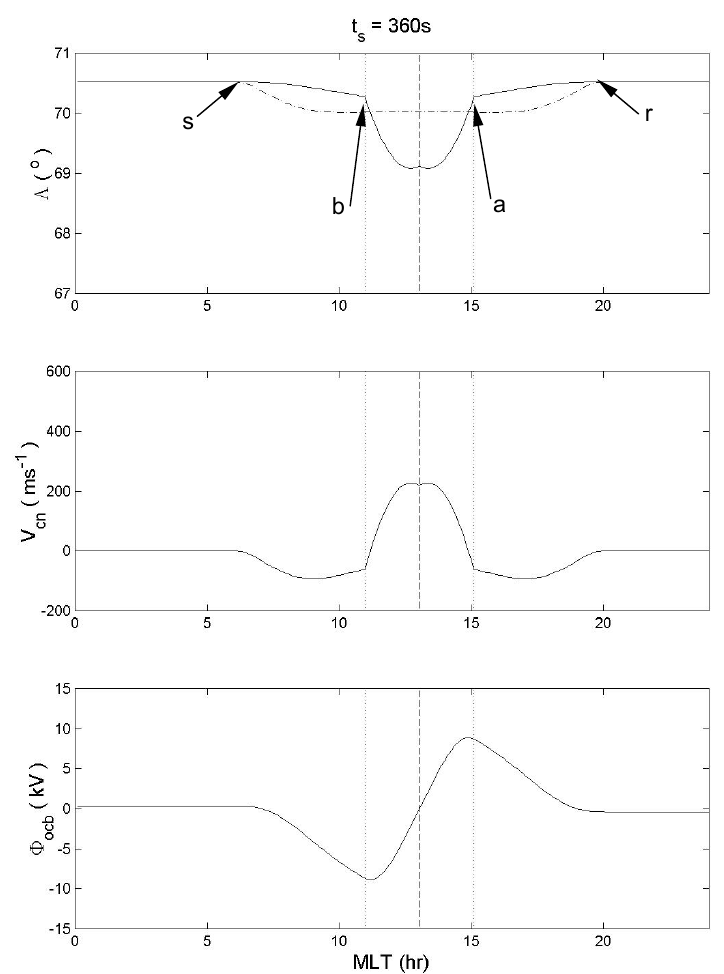
Fig. 5. Same as Fig. 4, but for simulation time t s =